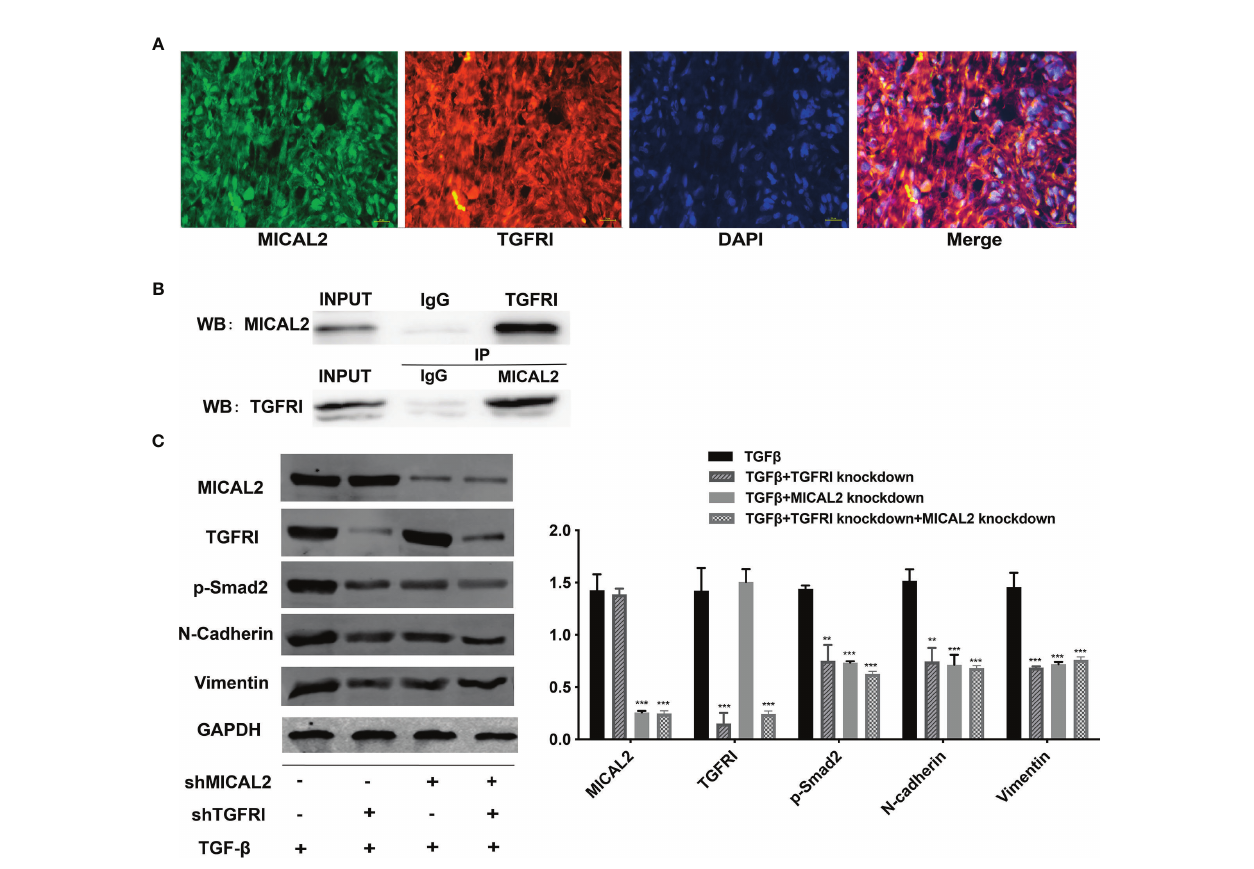
FIGURE 5 | MICAL2 interacts with TGFRI. (A) Immuno fl uorescence was used to detect MICAL2 and TGFRI position in GBM cells. (B) Lysates of GBM cells were immunoprecipitated with anti-IgG, anti-MICAL2, or anti-TGFRI antibodies, respectively, and the products were analyzed by Western blotting with the indicated antibodies. (C) MICAL2, TGFRI, p-Smad2, and EMT relative protein (N-cadherin and vimentin) expression were detected via Western blotting. Data are shown as the means ± SEM of three experiments.Asterisk represents comparing with the TGF- b -induced group; ** p < 0.01, *** p <